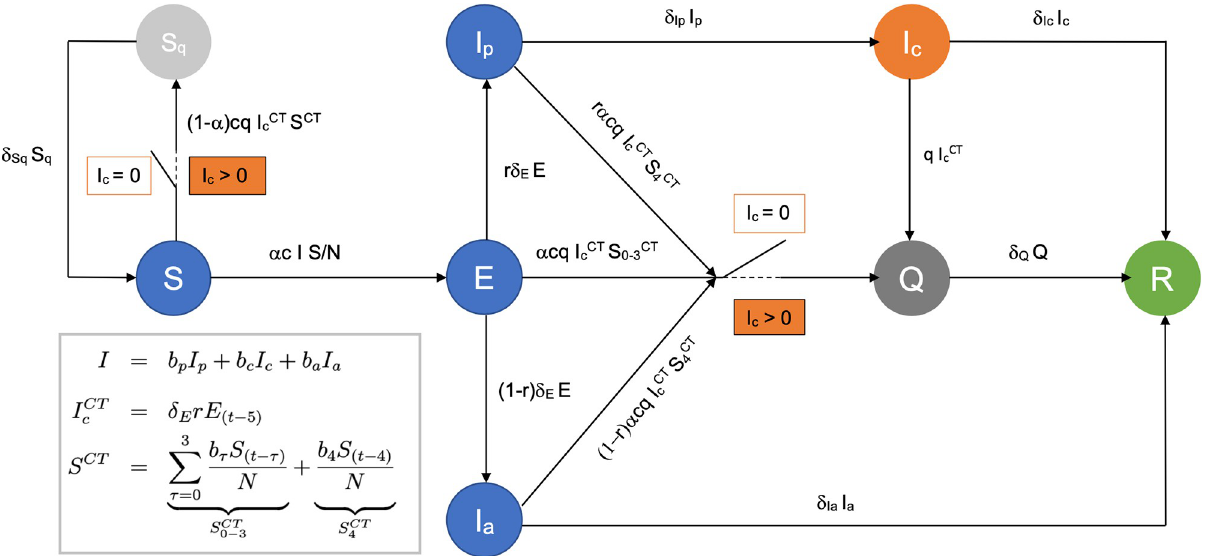
Fig 1. A schematic representation of the flow of individuals among different compartments as described by the system of Eq (11). Model parameters are described in Table 1. Susceptible individuals S can become exposed E after having interacted with an infected person, and successively become infectious pre-symptomatic I , symptomatic I , or asymptomatic I . Individuals in states represented in blue are not aware of their infectious p c a status and behave normally in the population. Individuals in I , represented in orange, can become aware of their status and be contact traced, where I CT c represents the number of people whose contacts are being traced today (see Eq (6)) and S CT is the total number of identified contacts that each contact tracing individuals has had in the past five days (see Eq (7)). Once contact tracing is activated (for I > 0, see Eq (5)) contacts can be moved to c quarantine (states in grey), where contacts developing an infection will enter the Q class, and contacts not developing an infection will enter the S q class. Recovered individuals enter the R status (in green). Delays in outbreak detection are modelled by assuming that contact tracing activates only when > I � , rather than when I > 0 (see Appendix A.4 in S1 File). I c c c